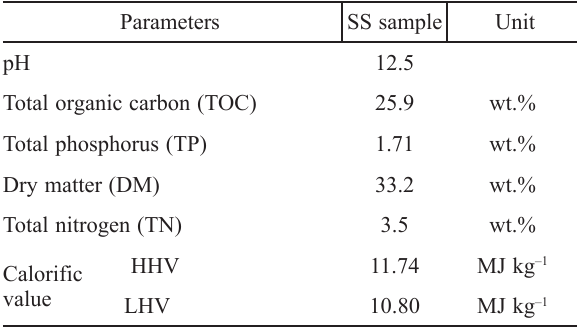
Table 1 – Physicochemical properties of SS Parameters SS sample